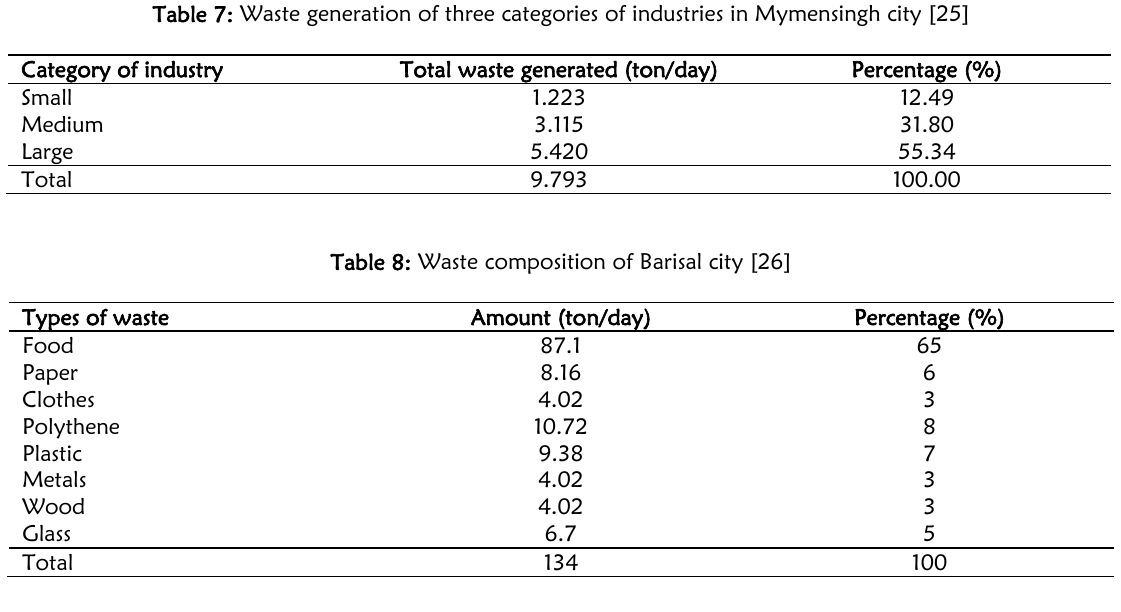
Table 7: Waste generation of three categories of industries in Mymensingh city [25]